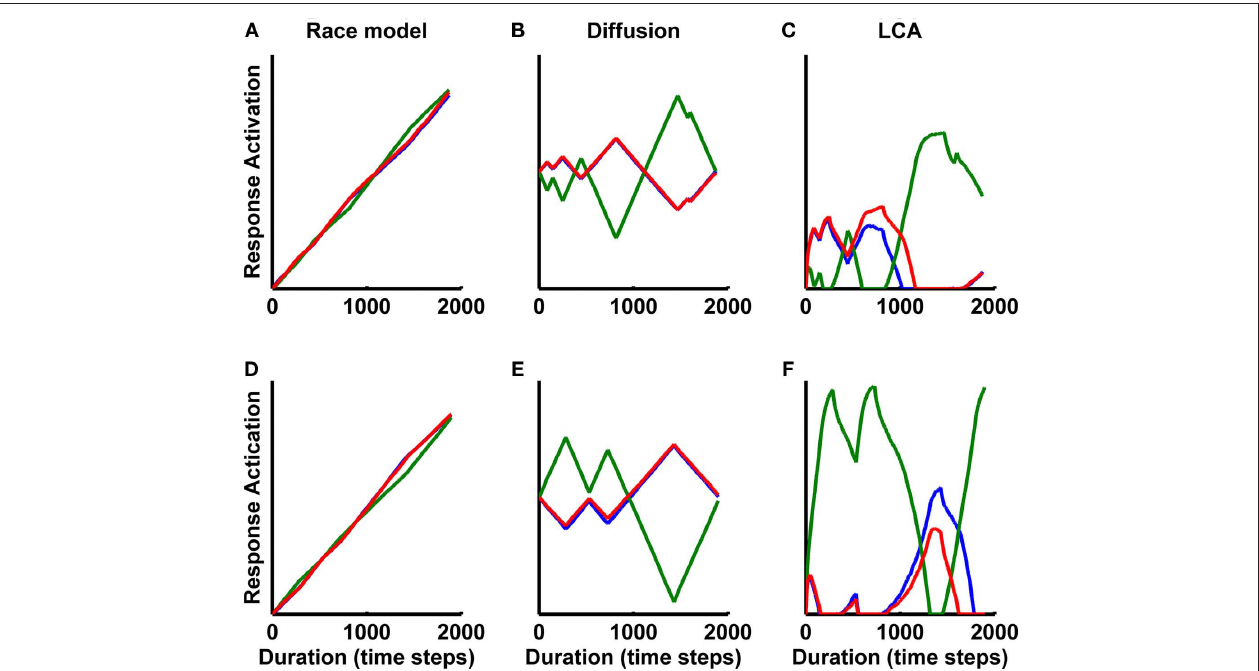
Figure 5 | Single trial activations for race (left panels), diffusion (middle panels), and LCA (right panels) for initial evidence supporting [(A,B) (top panels)] and supporting [(C) (bottom panels)]. The same two random streams (top/bottom panels) of evidence were used for all the models shown in